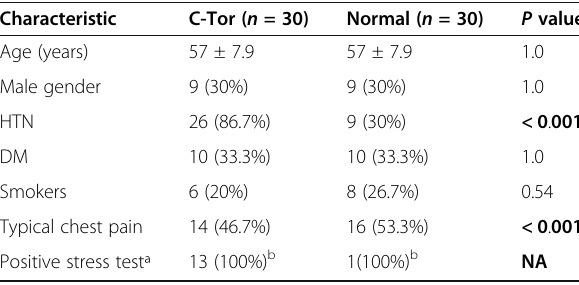
Table 2 Baseline demographics and clinical characteristics of the patients with and without coronary tortuosity Characteristic C-Tor ( n = 30)